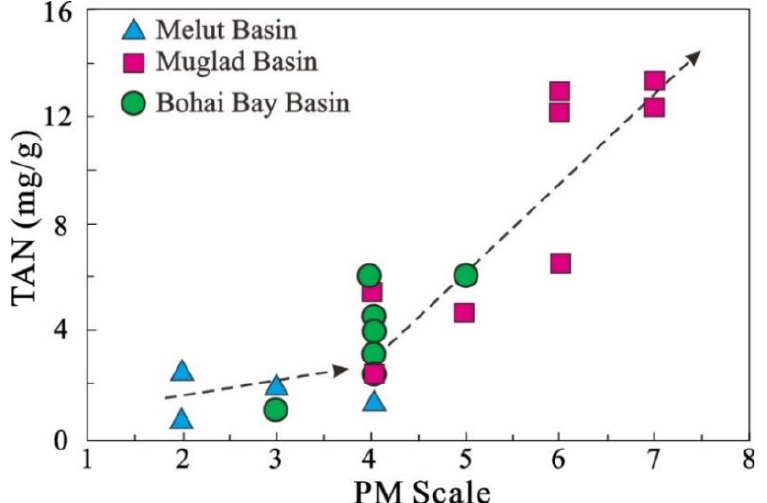
Figure 15. Cross plot of the degree of biodegradation (PM Scale) versus total acid number (TAN). Data from Dou [70]